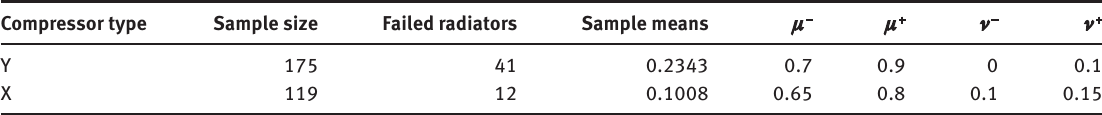
Table 3: IVIF Failure Data Regarding Two Types of Radiators (Infinite